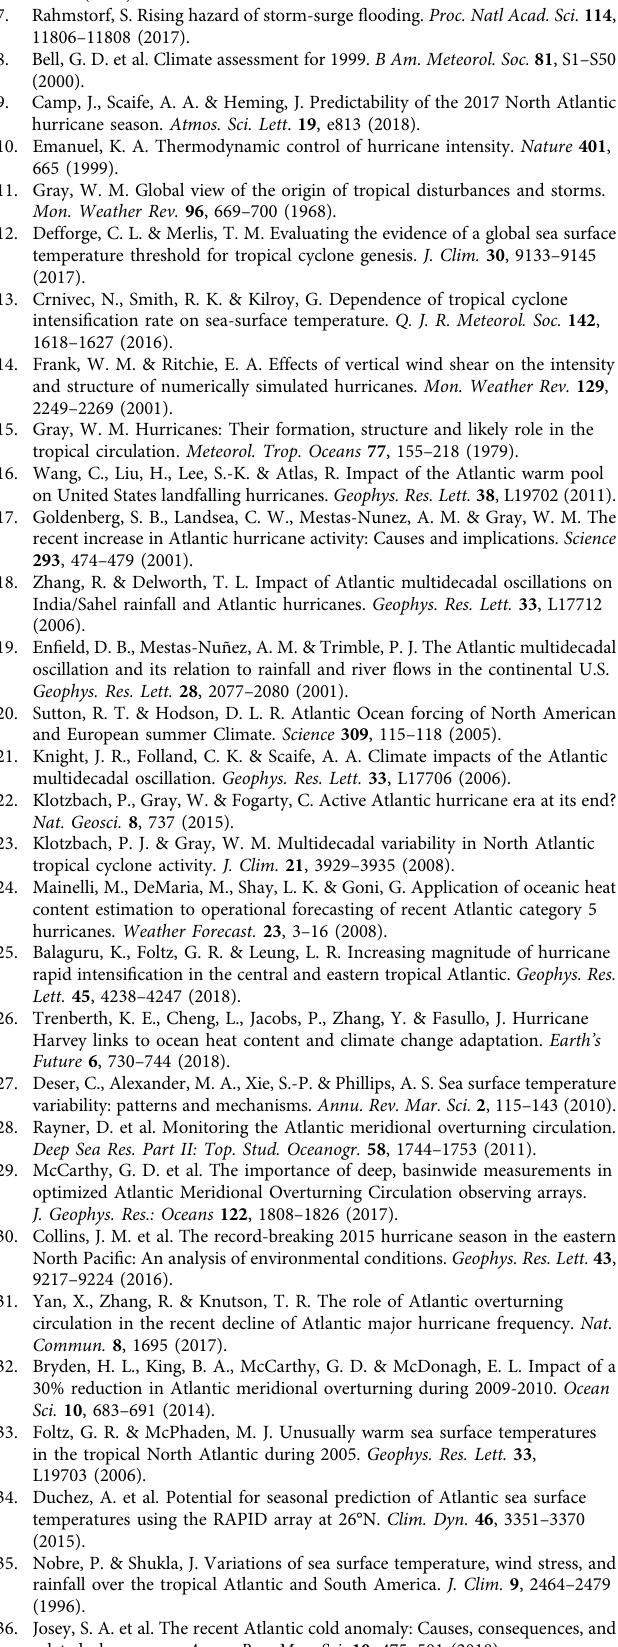
The estimated ocean temperature anomalies ( Δ T ) used in Fig. 5b and c are based on the surface fl ux anomalies (SFXA) and calculated as follows: